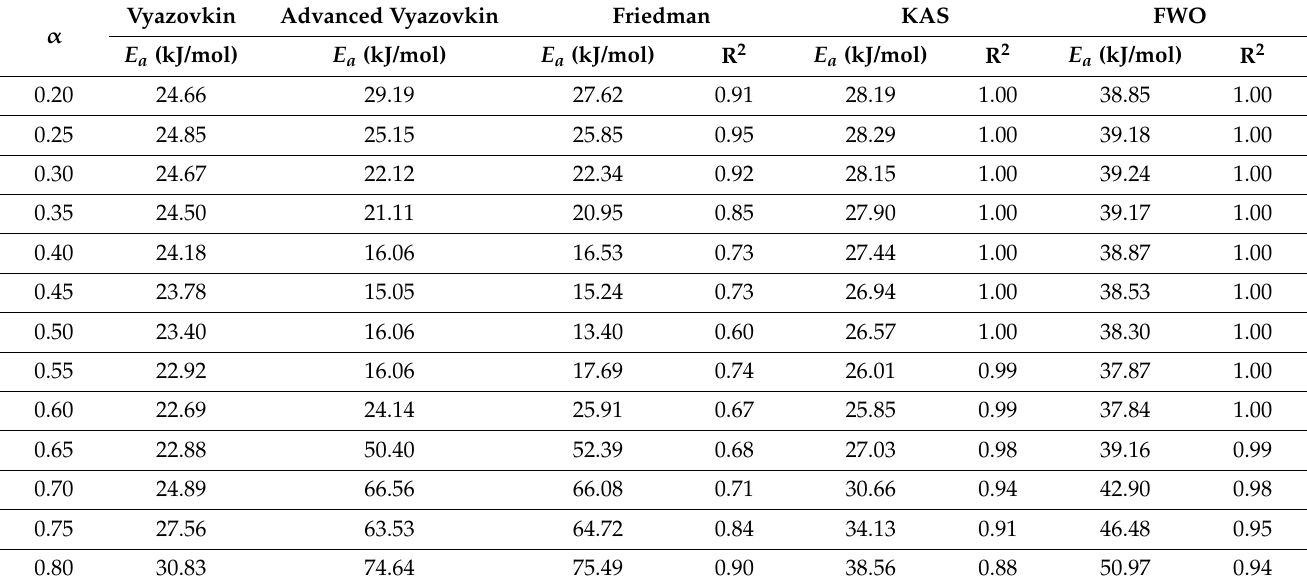
Table 3. Summary of E a and R 2 obtained from the fittings of each